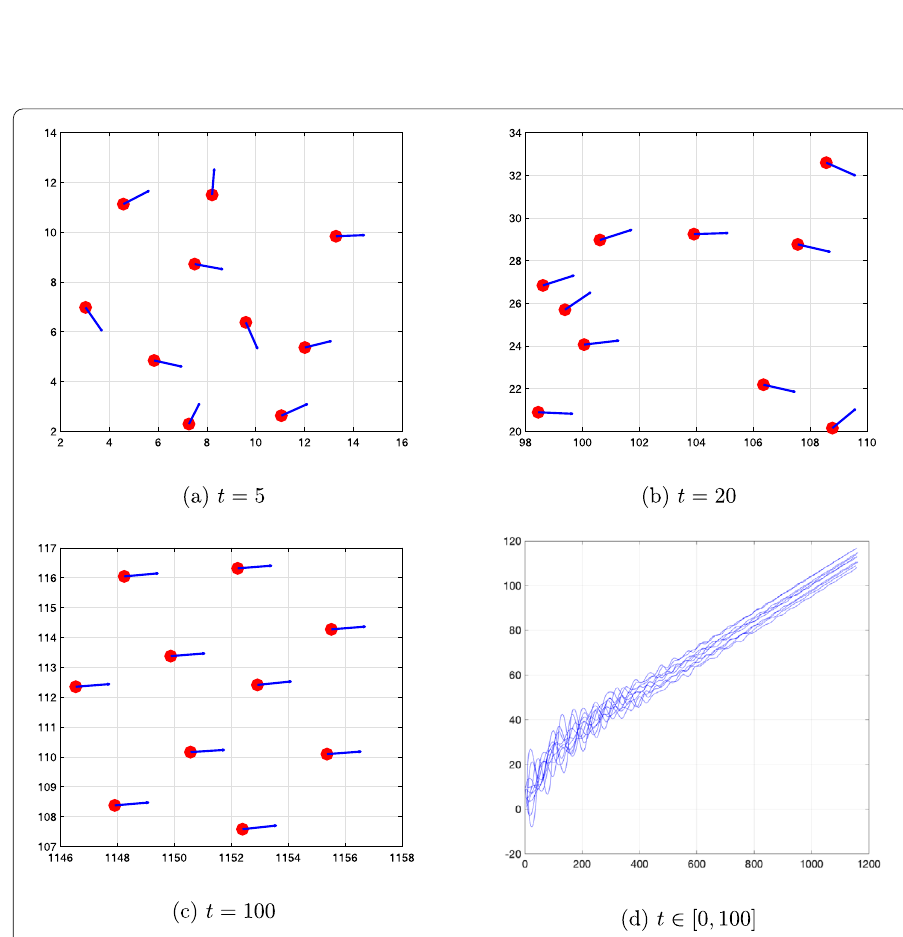
Figure 13 Simulation of the second-order swarming model with time delay ( τ = 5) for five agents, N = 10, and time t ∈ [0,1000]. The corresponding parameters are given as α = 0.7, β = 0.5, C a = 1, l a = 100, C r = 2, and l r = 1. The position of each agent is depicted by a circle and the velocity is represented by a vector at agent’s